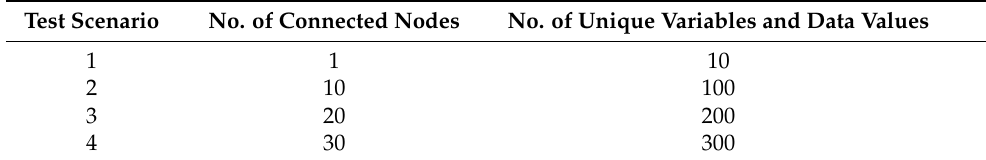
Table 2. Test scenarios in our